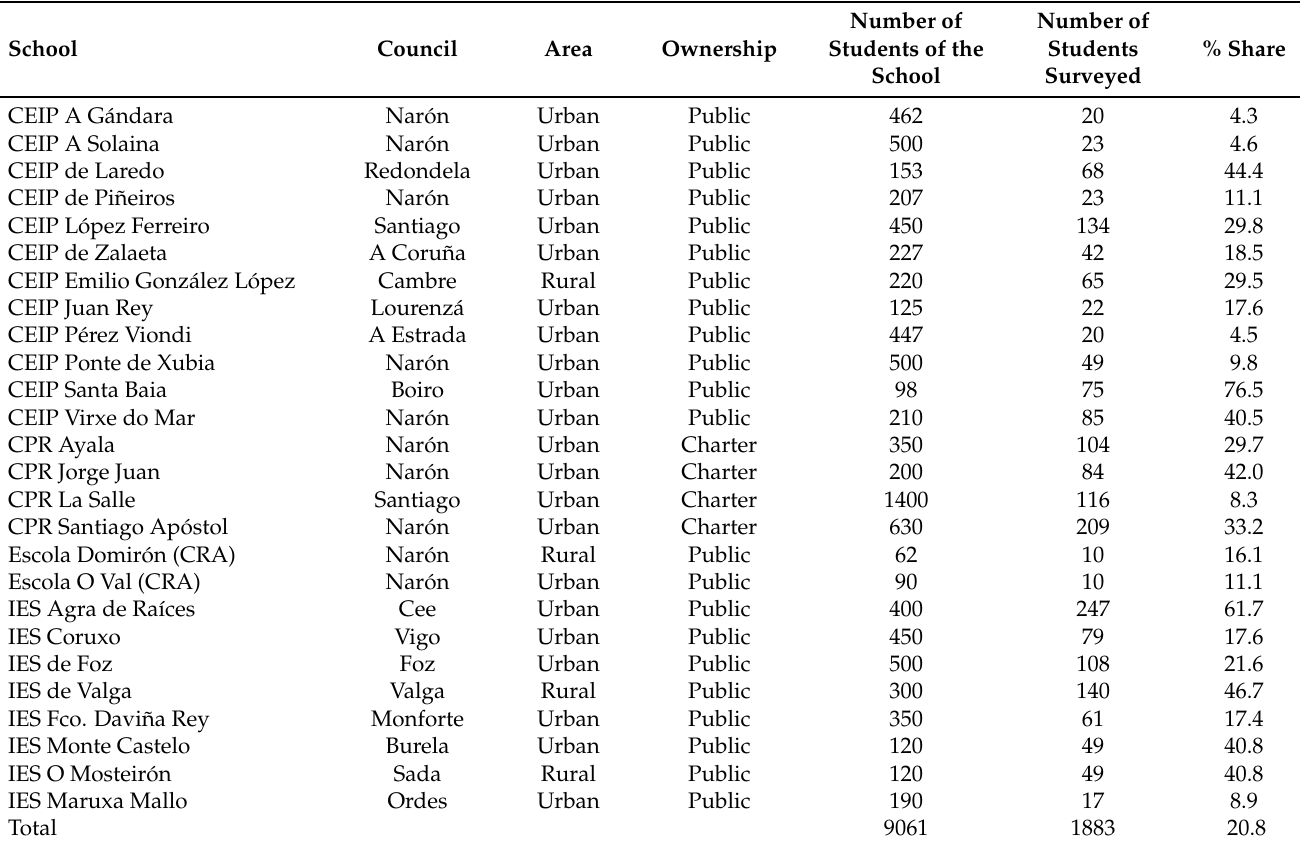
Table 3. Schools participating in the Geomove